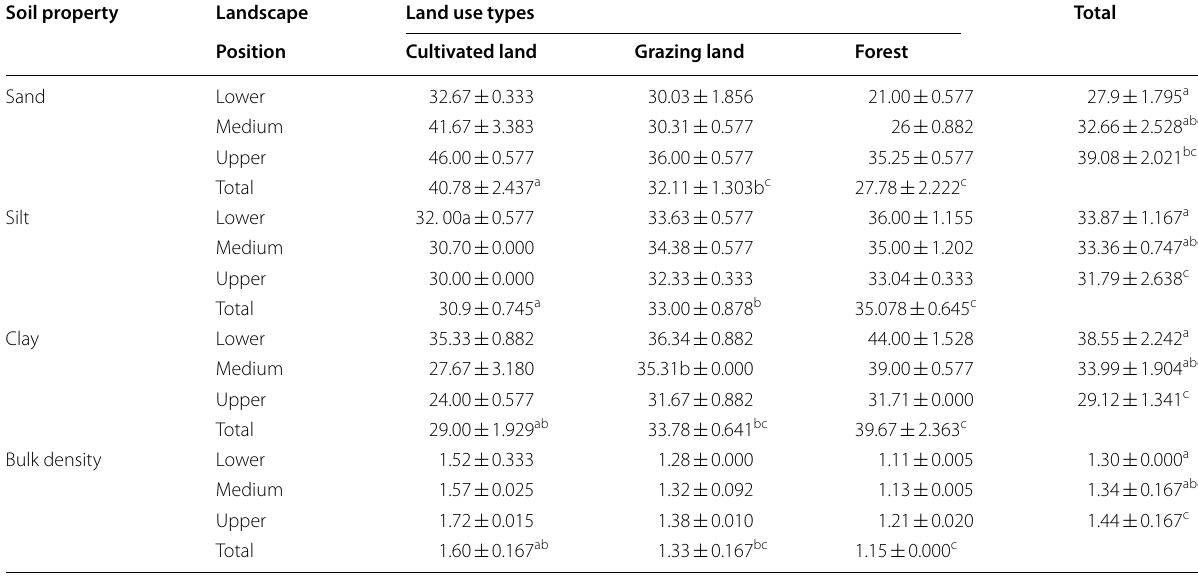
Means in the same row for land use and in the same column for landscape position followed by the similar letters are not significantly different at (p